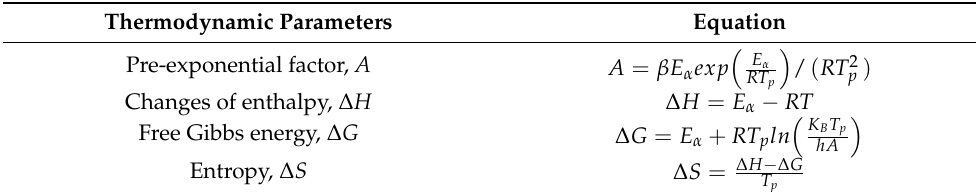
Table 1. Thermodynamic parameters equation [42].